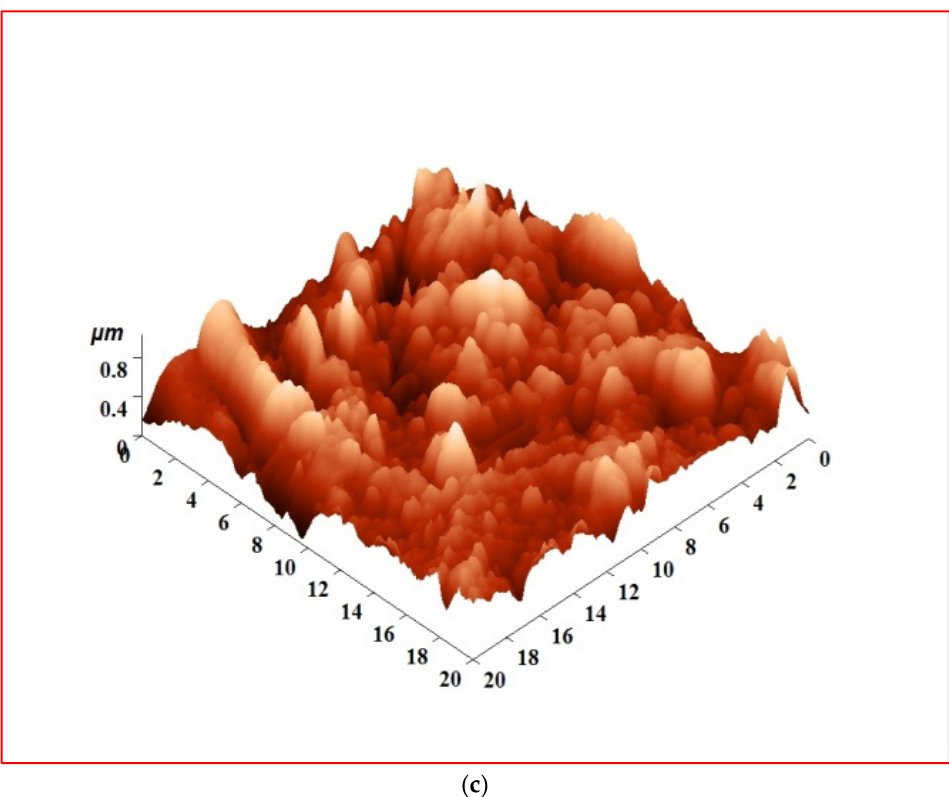
Figure 12. ( a ) AFM analysis of machined surface under SAE20W40. ( b ) AFM analysis of machined surface under veg oil. ( c ) AFM analysis of machined surface under veg oil + TiO 2 .